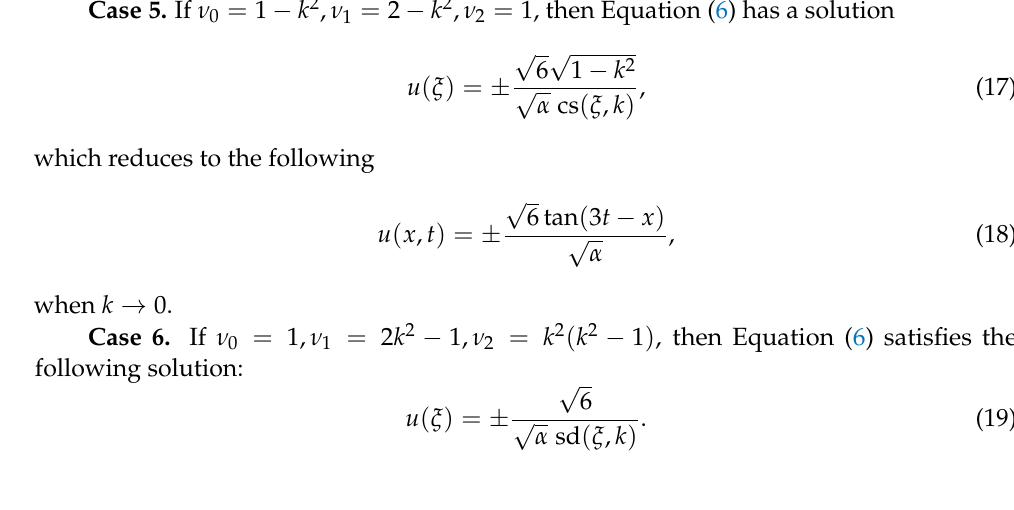
Figure 2. The graphs ( a , b ) are the 3D plots of the positive solutions (15), (16), respectively. In ( a ), k =